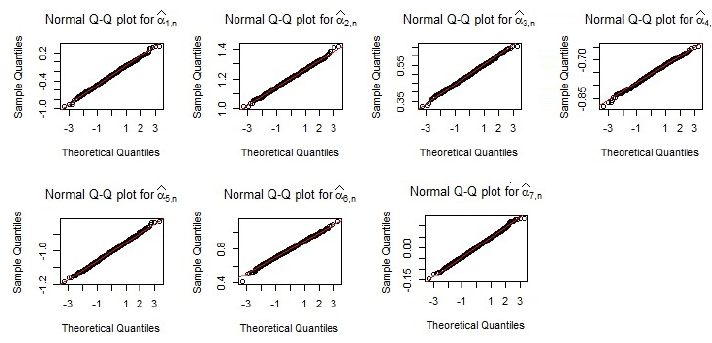
Fig. 1: Normal Q - Q plots for (cid:98) α 1 ,n ,..., (cid:98) α 7 ,n with results are obtained from the maxLik function (n = 500)